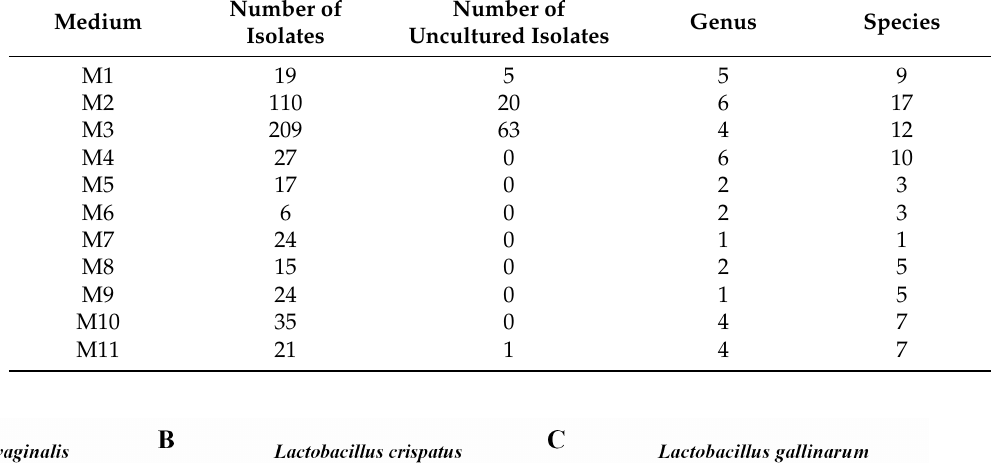
Table 1. The statistics of isolates from the chicken intestine. Medium